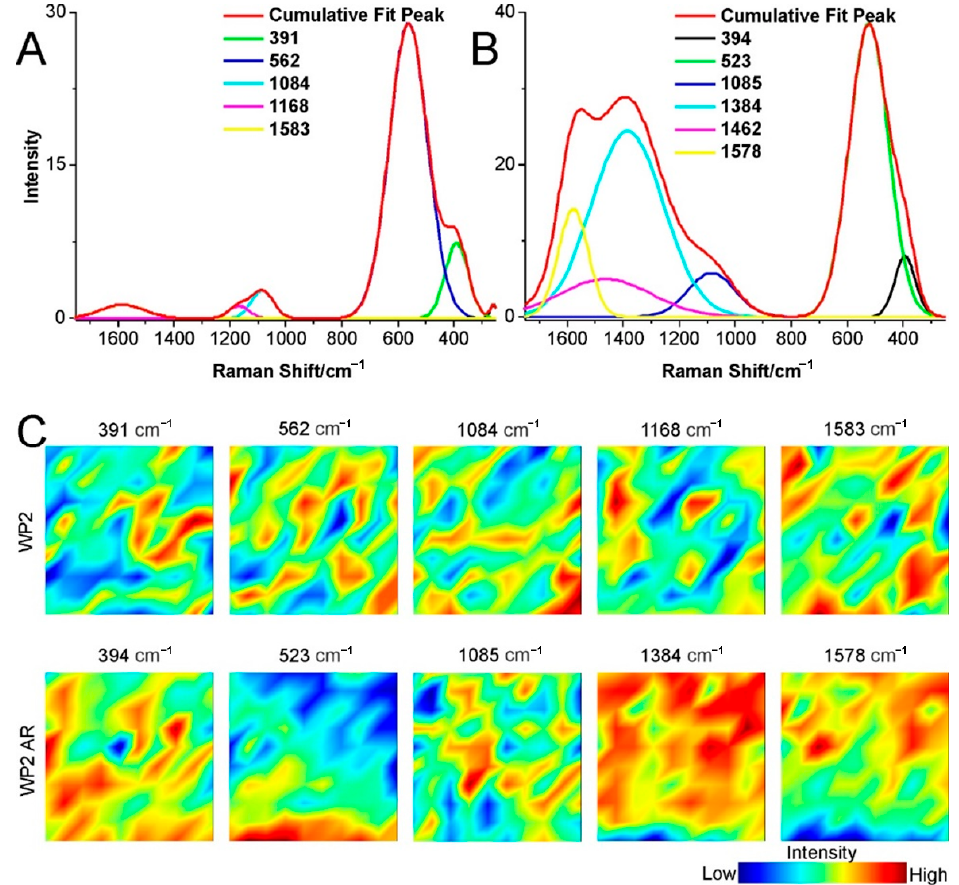
Figure 8. Deconvoluted Raman spectra of the WP2 ( A ) before and ( B ) after the reaction. ( C ) Raman maps with the distribution of selected WP2 bands (top row) before and (bottom row) after the reaction. Red spectra correspond to the cumulative spectrum consisting of the deconvoluted bands. Other colors of spectra correspond to the single deconvoluted bands.